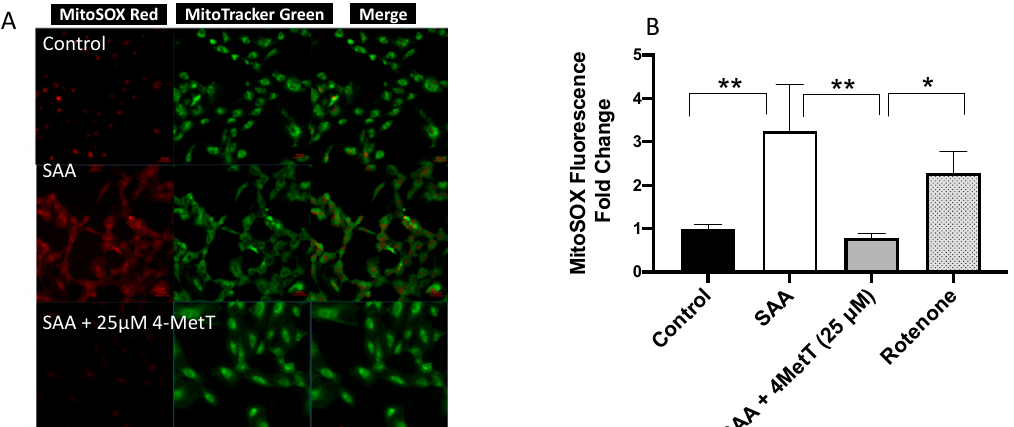
Figure 6. Mitochondrial ROS (mtROS) in cultured primary HAEC in response to SAA and 4-MetT. The mitochondrial specific fluorescent probe MitoSOX Red was used to quantify the production of mtROS in response to SAA and 4-MetT in HAEC (see Methods Section). Cells were treated with 10 µg/mL SAA at either 6 h and with or without 25 µM 4-MetT pretreatment for 24 h, or DMSO (vehicle control) in both independent runs. Rotenone was used as positive control that has known impact on cell respiration, and it confirmed that the experimental model was functioning as anticipated in the presence of the mitochondrial complex 1 inhibitor. ( A ). Images captured via fluorescent microscopy at ×20 magnification using an appropriate filter set. MitoTracker green was used as a control to fluorescently label mitochondria within the cell to show a co-localisation of the MitoSOX Red fluorescence (merge image; scale bar 20 µm; n = 4). ( B ). Fluorescence was measured at λ excitation /510/ λ emission 580 nm respectively after 30 min MitoSOX incubation using an Infinite ® M200 PRO Plate reader (Tecan, Männedorf, Germany). Data represent mean ± SD, n = 3 independent biological replicates, and were normalised against corresponding total cellular protein and expressed as relative fold change compared to the control (arbitrability assigned a value of 1). * p < 0.05; ** p < 0.005.